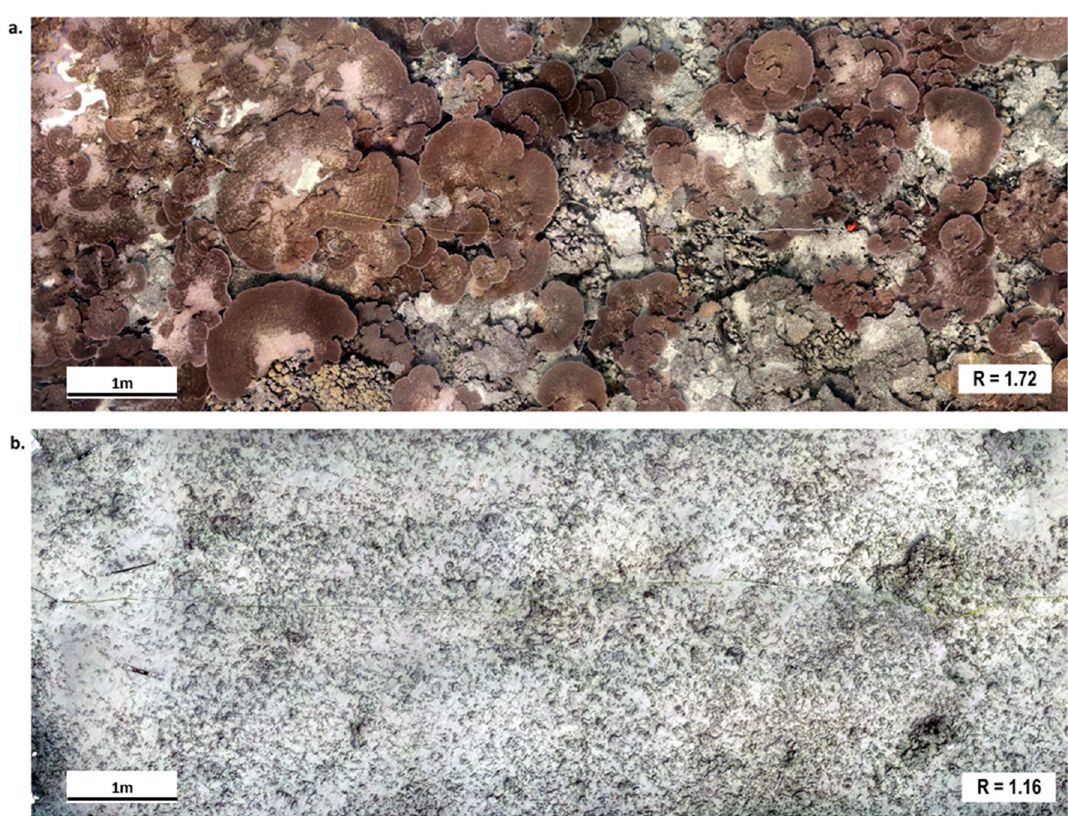
Figure 2. Orthophotomosaic (10 × 5-m) of the coral reef habitat and reef rugosity measurements (R) at Rapture Reef ( a ) before (September 2017) and ( b ) after (July 2019) Hurricane